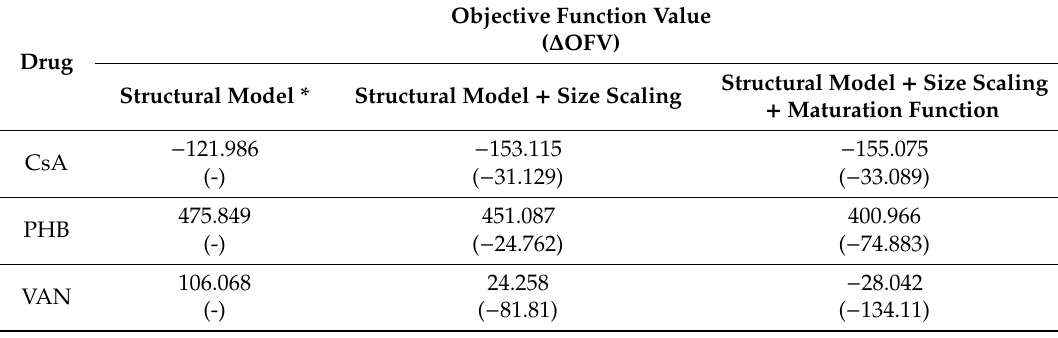
Table 2. Objective function value (OFV) of pharmacokinetic (PK) models for cyclosporine A (CsA), phenobarbital (PHB) and vancomycin (VAN) .